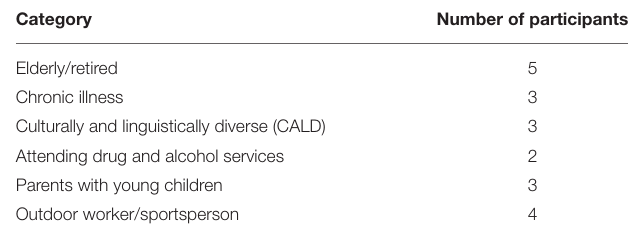
TABLE 1 | Participant